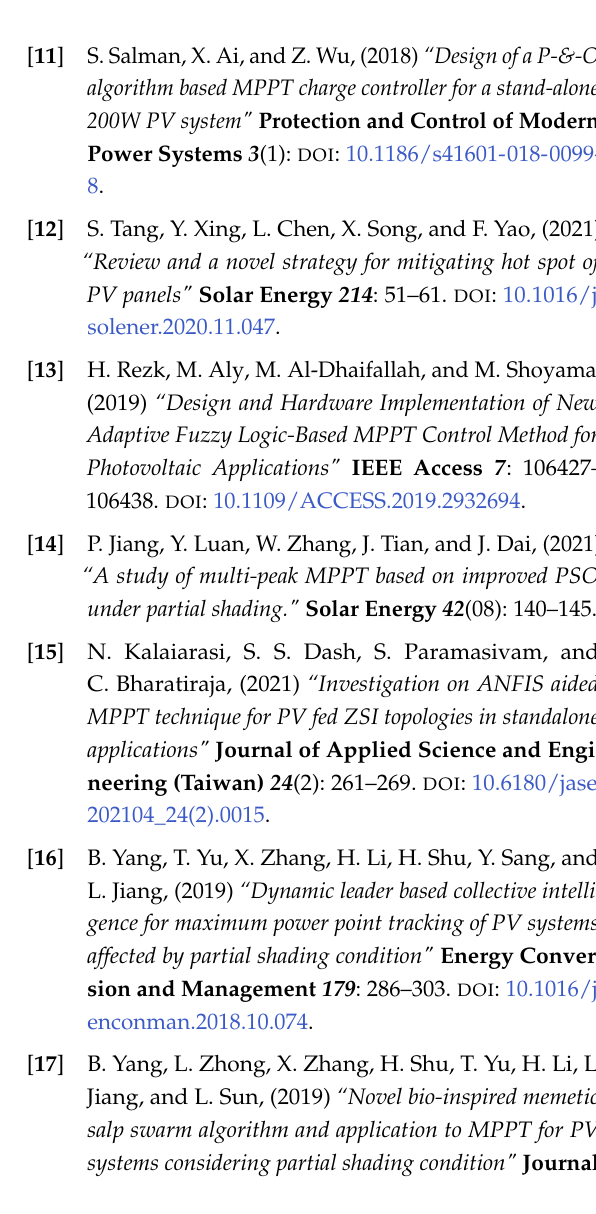
algorithm based MPPT charge controller for a